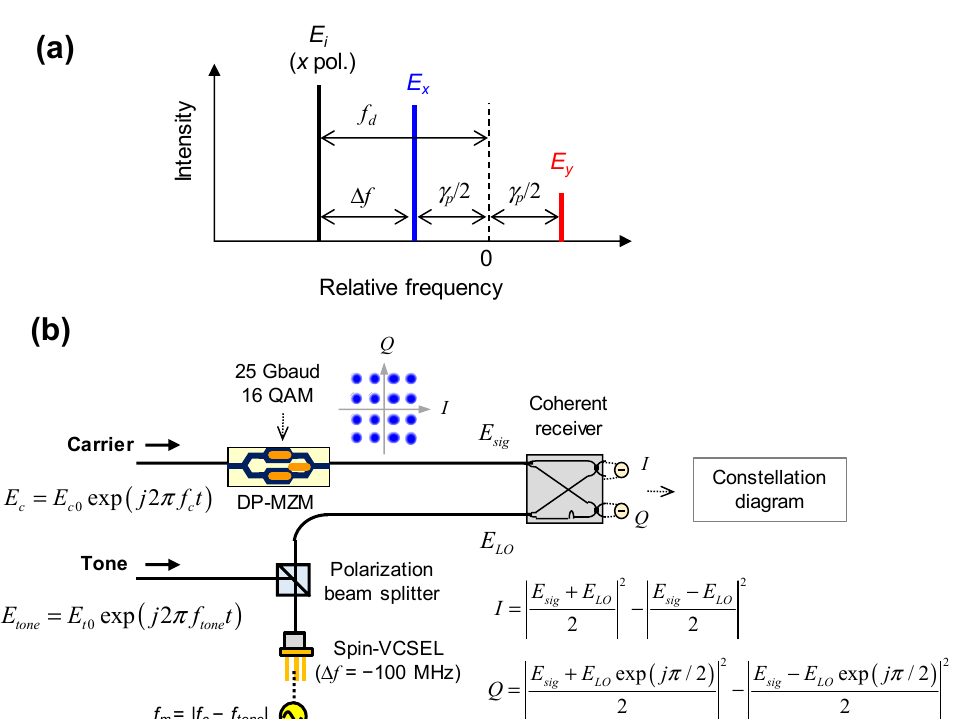
Figure 3. ( a ) Schematic of detuning condition for injection locking; ( b ) Schematic of proof-of-concept simulation of frequency-shifted LO based on injection-locked spin-VCSEL for homodyne detection.